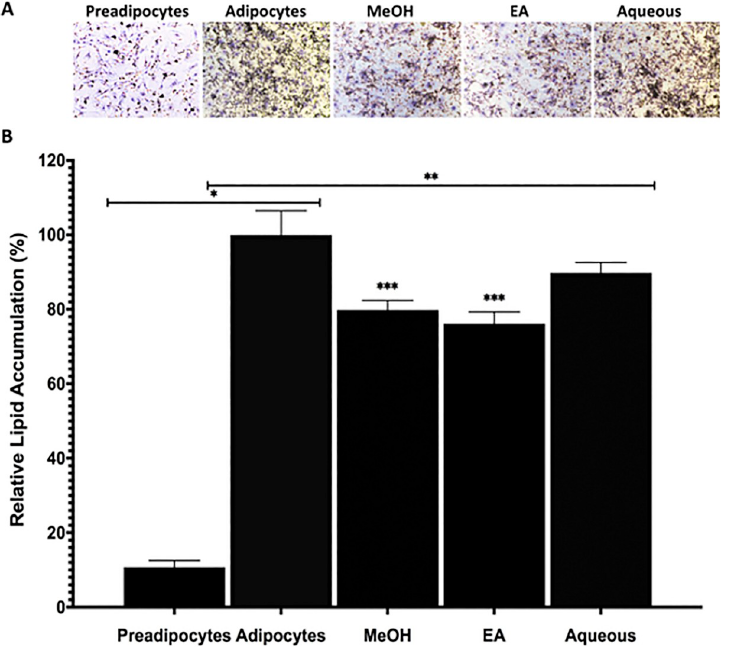
Fig 3. Oil Red O staining showing 3T3-L1 preadipocyte cells differentiated into mature adipocytes and effects B . spergulifolius extracts on lipid accumulation in 3T3-L1 cells. A. The microscopic images at 10X magnification of lipid droplet of preadipocytes, mature adipocytes without B . spergulifolius extracts and adipocytes treated with IC 50 dose of MeOH, EA and Aqueous of B . spergulifolius extracts stained with Oil Red O (Scale bar: 100 μ m) B. The relative lipid quantization of preadipocytes, mature adipocytes treated without B . spergulifolius extracts and with MeOH, EA, Aqueous of B . spergulifolius extracts . OD 490 of Oil Red O staining from three independent experiments was measured. Data are expressed as the relative change of the OD 490 and presented as the means ± SD. To analyze statistical was used One-way ANOVA test. � p < 0.0001 and �� p < 0.001, significantly different from mature 3T3-L1 Adipocytes. ��� p < 0.001, significantly different from Aqueous. treated with IC doses of MeOH, EA and Aqueous B . spergulifolius extracts for 24 h. Com- 50 pared to preadipocytes, Bax and Bcl-2 genes at mRNA level expression were decreased by 23.22 ± 0.04% and 24.46 ± 1.70% but Bax/Bcl-2 ratio increased by 1.654 ± 0.01%, respectively in untreated adipocytes (p = 0.0015, p < 0.0001, and p = 0.3451). Pro-apoptotic Bax gene at mRNA level expression increased by, respectively, 264.05 ± 0.9%, 347.90 ± 0.57% and 161.64 ± 0.30% in mature 3T3-L1 adipocytes treated with B . spergulifolius MeOH, EA and Aqueous extracts compared to untreated adipocytes, while the anti-apoptotic Bcl-2 gene at mRNA level decreased by 15.71 ± 0.14%, 49.01 ± 0.57%, and 18.13 ± 0.15%, respectively (for Bax , p = 0.0020, p = 0.0002, p = 0.0003, and for Bcl-2 p = 0.0343, p < 0.0001, P = 0.0423, respec- tively). However, compared to B . spergulifolius Aqueous extract, an increase in the expression level of the Bax gene was 36.14% and 71.18%, respectively, in MeOH and EA extract treatment groups, while the expression level of the Bcl-2 gene increased by 2.96% and 37.71%, respec- tively (MeOH-EA, EA-Aqueous, MeOH-Aqueous, for Bax p = 0.0919, p = 0.0039, p = 0.0131 and for Bcl-2 p = 0.0025, p = 0.0083, p = 0.6994, respectively). Similarly, compared to untreated adipocytes, B . spergulifolius MeOH, EA and Aqueous treatment groups mature 3T3-L1 adipo- cytes showed an increase of 330.80%, 780.70%, and 22.18%, respectively in Bax/Bcl-2 (p = 0.0057, p = 0.0002 and p = 0.0134, respectively). In addition, compared to Aqueous extract, B . spergulifolius MeOH and EA extract treatments increased 33.71% and 173.35% respectively in Bax/Bcl-2 (EA-MeOH, EA-Aqueous, and MeOH-Aqueous p = 0.0062, p = 0.0025, and p = 0.0936, respectively) (Fig 4).